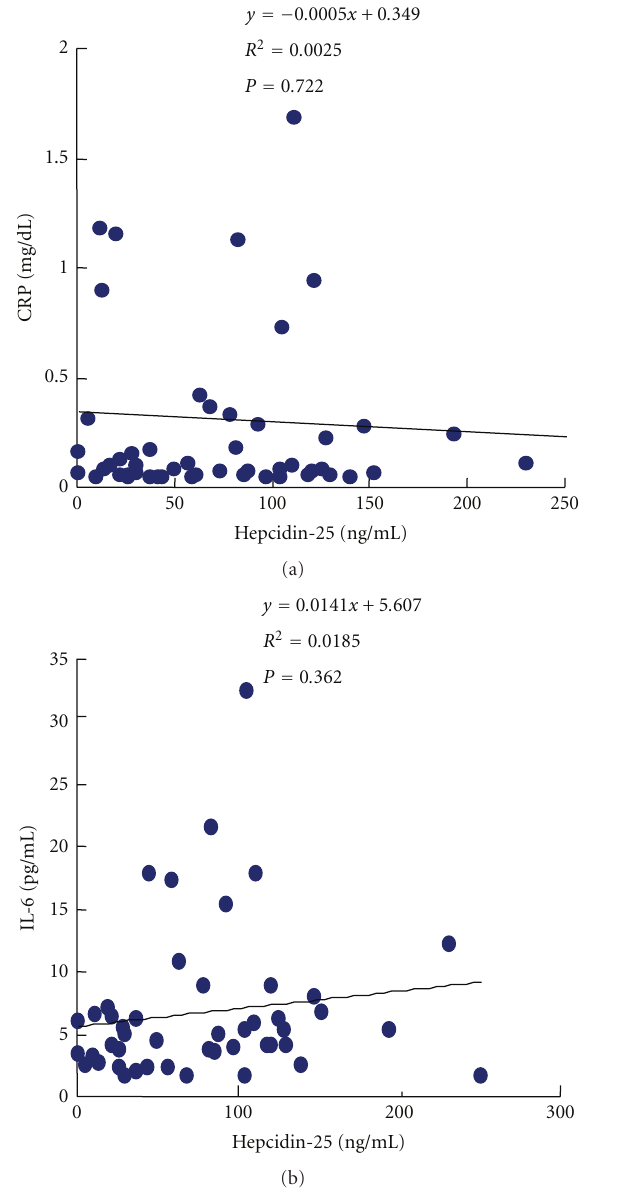
Figure 5: Correlation between serum hepcidin-25 levels and inflammation parameters. (a) Hepcidin and CRP. (b) Hepcidin and IL-6.